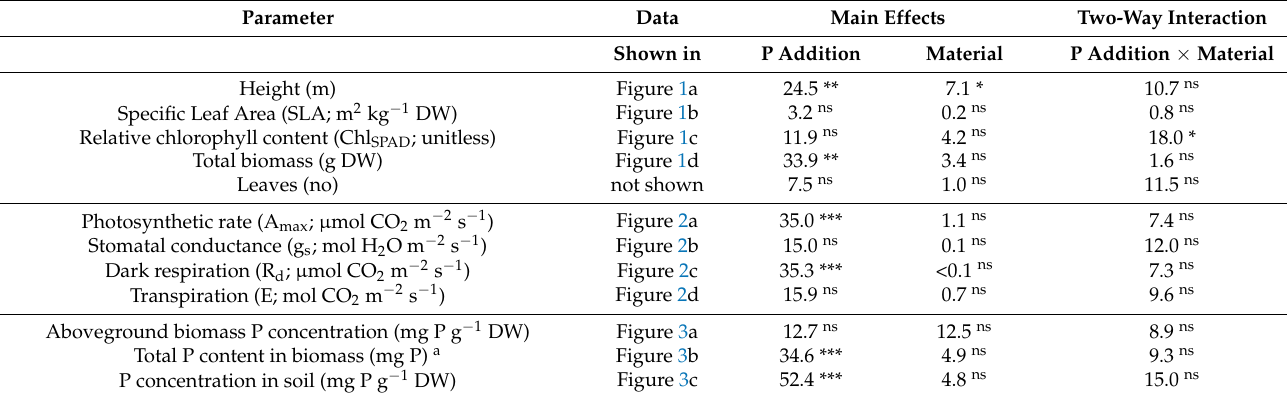
Table 1. Summary of two-way ANOVA (percentages of total sum of squares (%SS)), showing the effects of two materials (material I and II) and five levels of P addition (6, 12, 25, 50, and 100 kg P ha − 1 yr − 1 ). The experiment was performed on Zea mays in a growth chamber with controlled conditions and measurements were performed after the plants had grown for eight weeks in the treatments. The NPK and control treatments were excluded from the two-way ANOVA analysis, and the P addition has five levels (6, 12, 25, 50, 100 kg P ha − 1 yr − 1 ) and the material effect has two levels (material I and II).